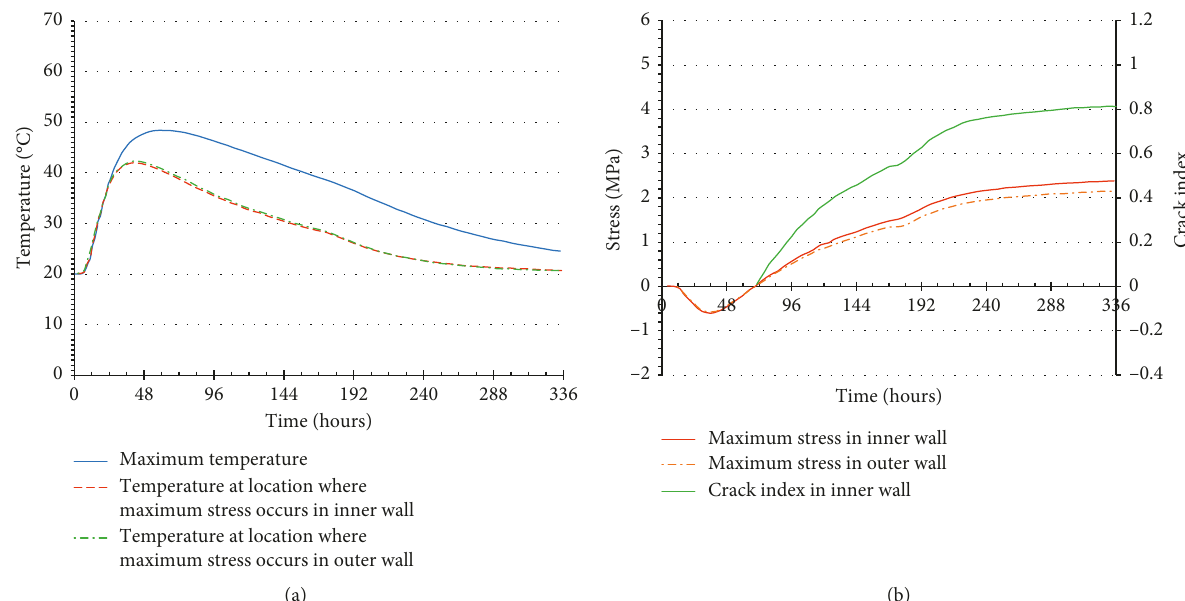
Figure 9: Calculated temperature (a) and stress (b) developments of 60% FA concrete.